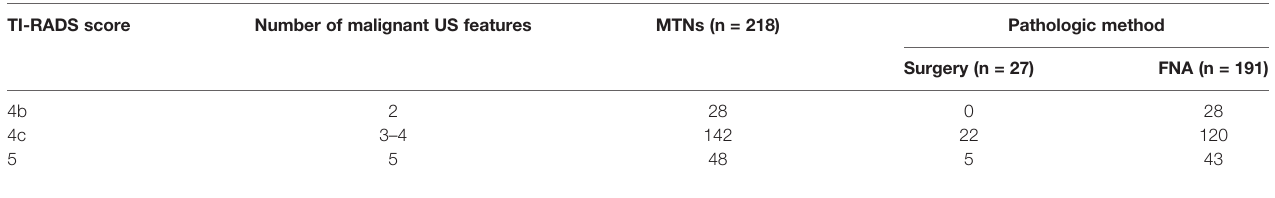
TABLE 1 | Diagnostic Performance of the MTNs by the Kwak TI-RADS. TI-RADS